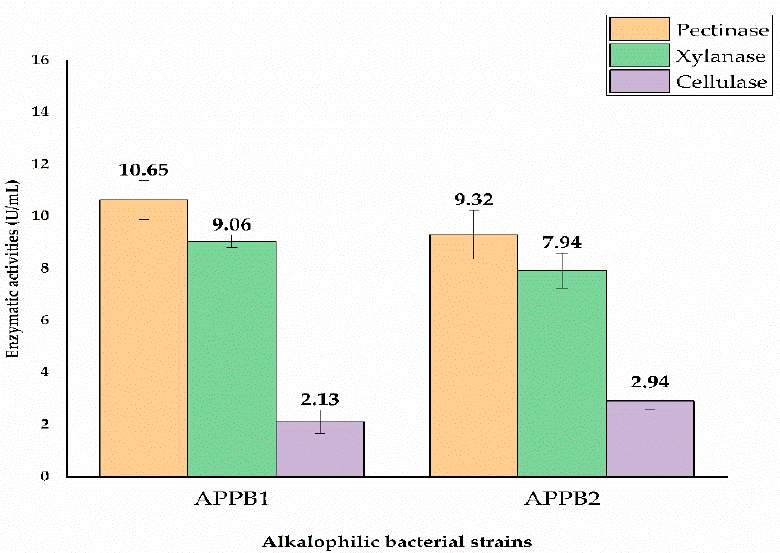
Figure 2. Quantitative pectinase, xylanase, and cellulase enzymatic activities of the alkalophilic bacterial isolates APPB1 and APPB2.